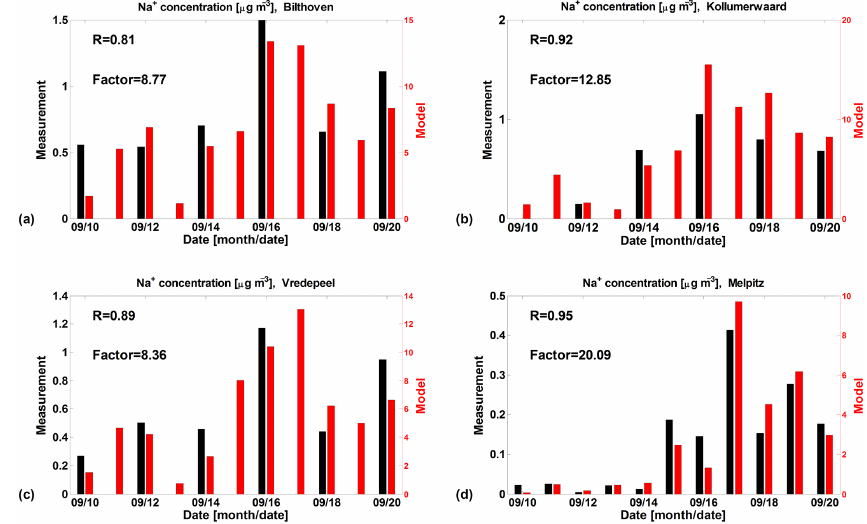
Figure 7. Comparison of Na + mass concentration in PM 10 between the filter sampler measurements (left y axis) in four EMEP stations and the F-CASE results (right y axis). (a) Bilthoven; (b) Kollumerwaard; (c) Vredepeel; (d) Melpitz. The locations of the stations are shown in Fig. 2.